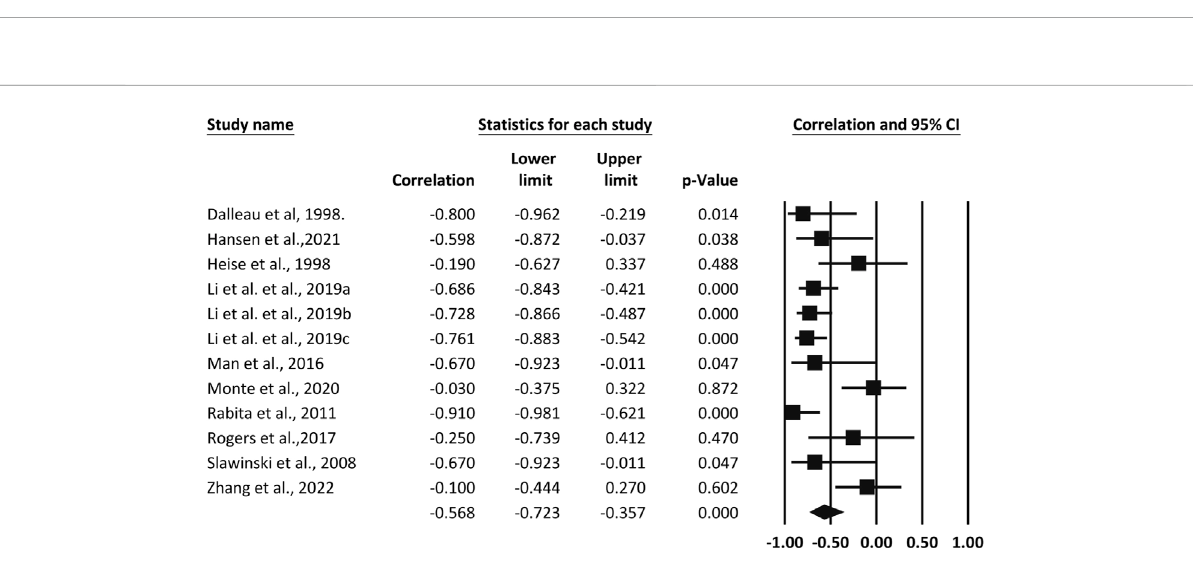
FIGURE 3 Forest plot of the correlation between leg stiffness and running economy. The superscripted letter in column 1 refer to speed or gender items assessed in the same